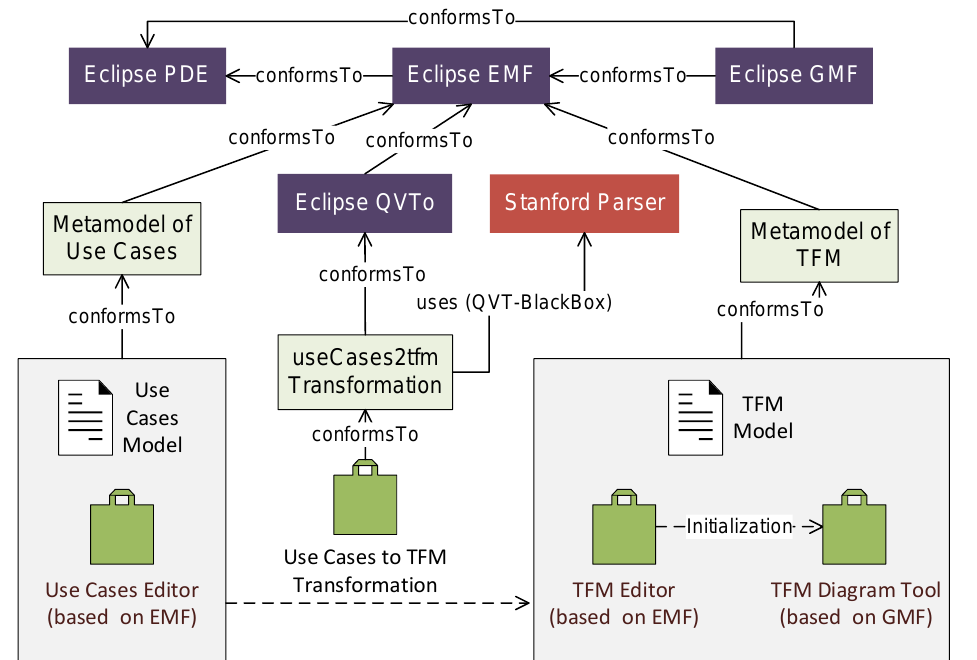
Fig. 2. Architecture of the IDM toolset. Dark rectangles on top represent the Eclipse framework used and also the Stanford Parser Java library. 3 lighter rectangles underneath show the development artifacts based on the frameworks and libraries created specifically for the IDM tools. The resulting toolset consists of 4 tools – Use Case Editor, TFM Editor, TFM Diagram Tool and Use Cases to TFM